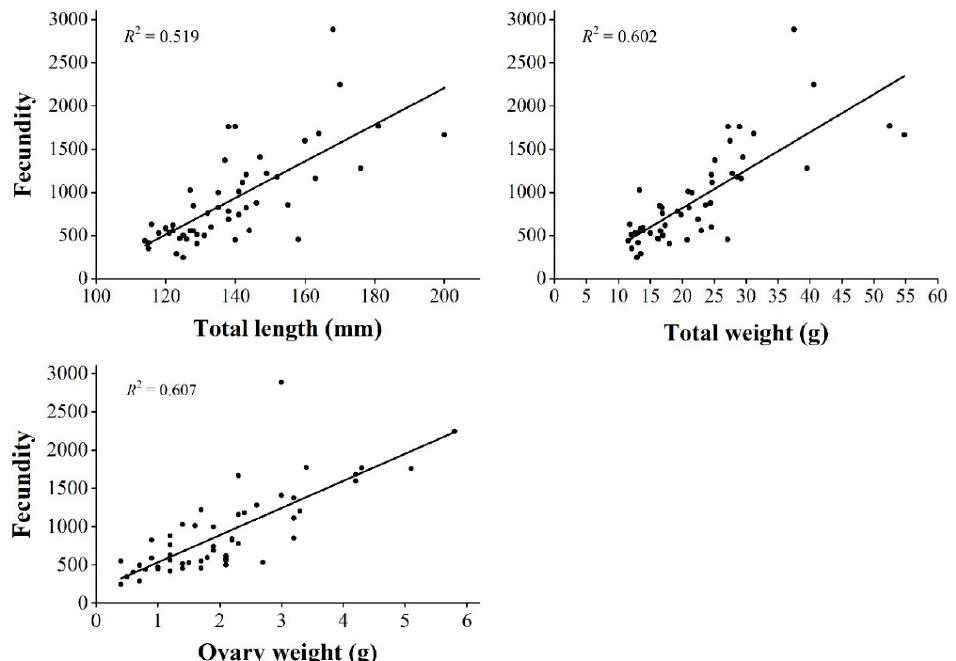
Figure 10. Relationships among the total length, total weight, ovary weight, and fecundity of Pseudecheneis sulcatus .